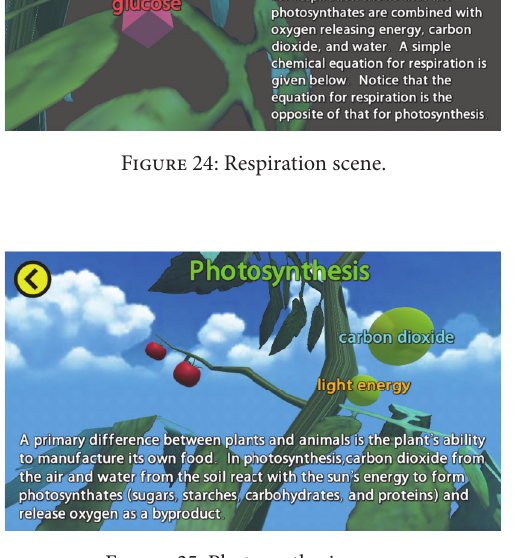
Figure 25: Photosynthesis scene.